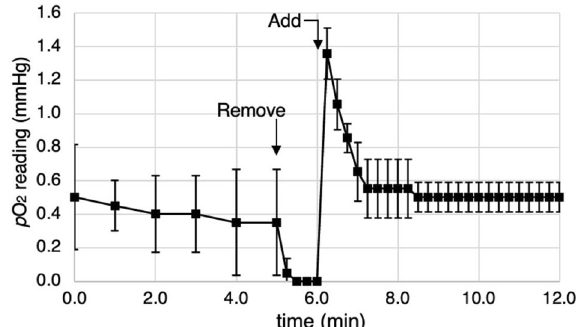
Figure 3. Time dependence of the oxygen levels measured at a point 100 μm above the membrane in the gas recirculation system when mimicking media change process with each well containing 200 μL of water. Water is removed at the 5 min timepoint and fresh pre-equilibrated water added at 6 min. The p O 2 was measured in a well in Row